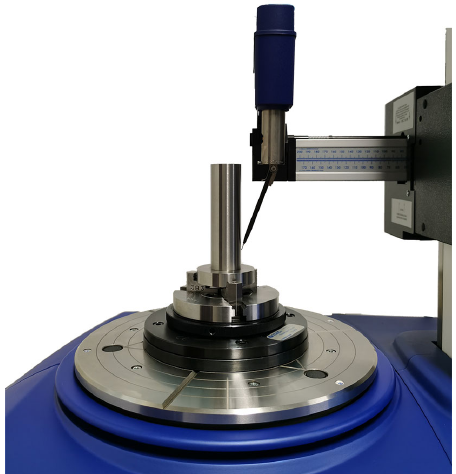
Figure 3. The roundness and cylindricity errors measurement process.